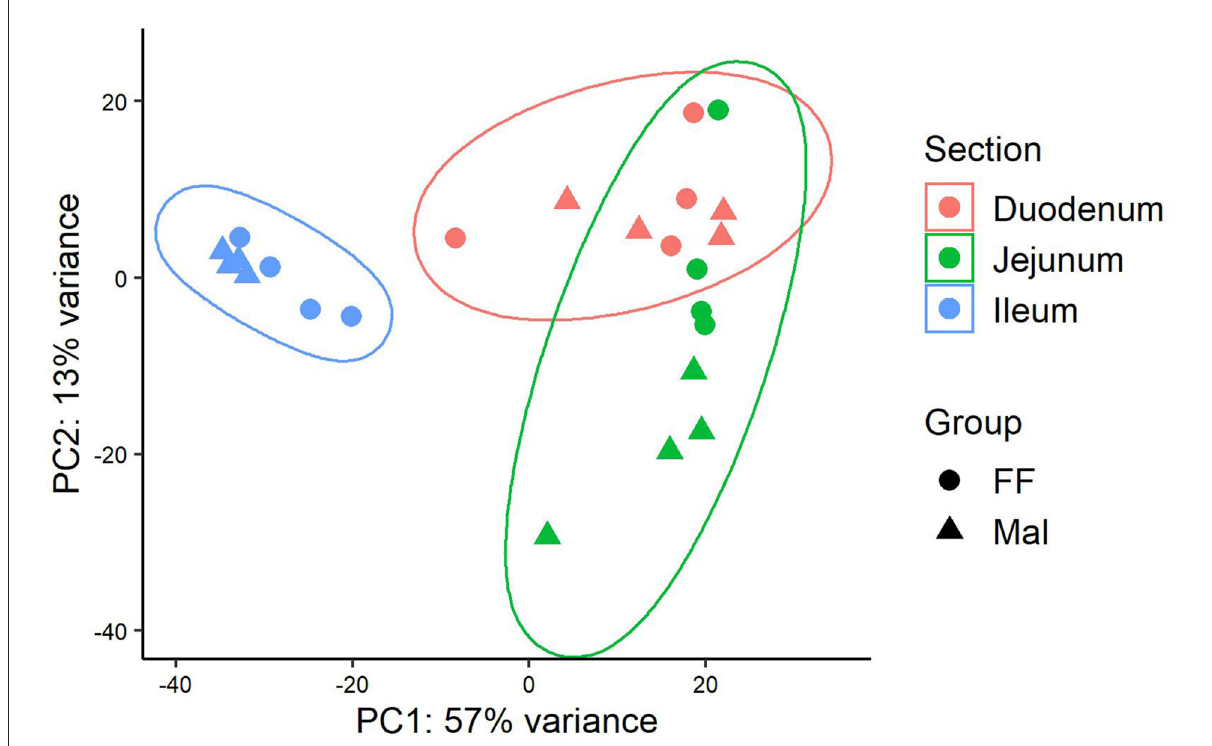
FIGURE1 Principal component analysis of gene expression along the length of the intestinal tract in full-fed and malnourished pigs. Principal component analysis of the rlog transformed reads from Salmon for the full-fed (FF, n = 4) and malnourished (Mal, n = 4) groups in the duodenum (pink), jejunum (green), and ileum